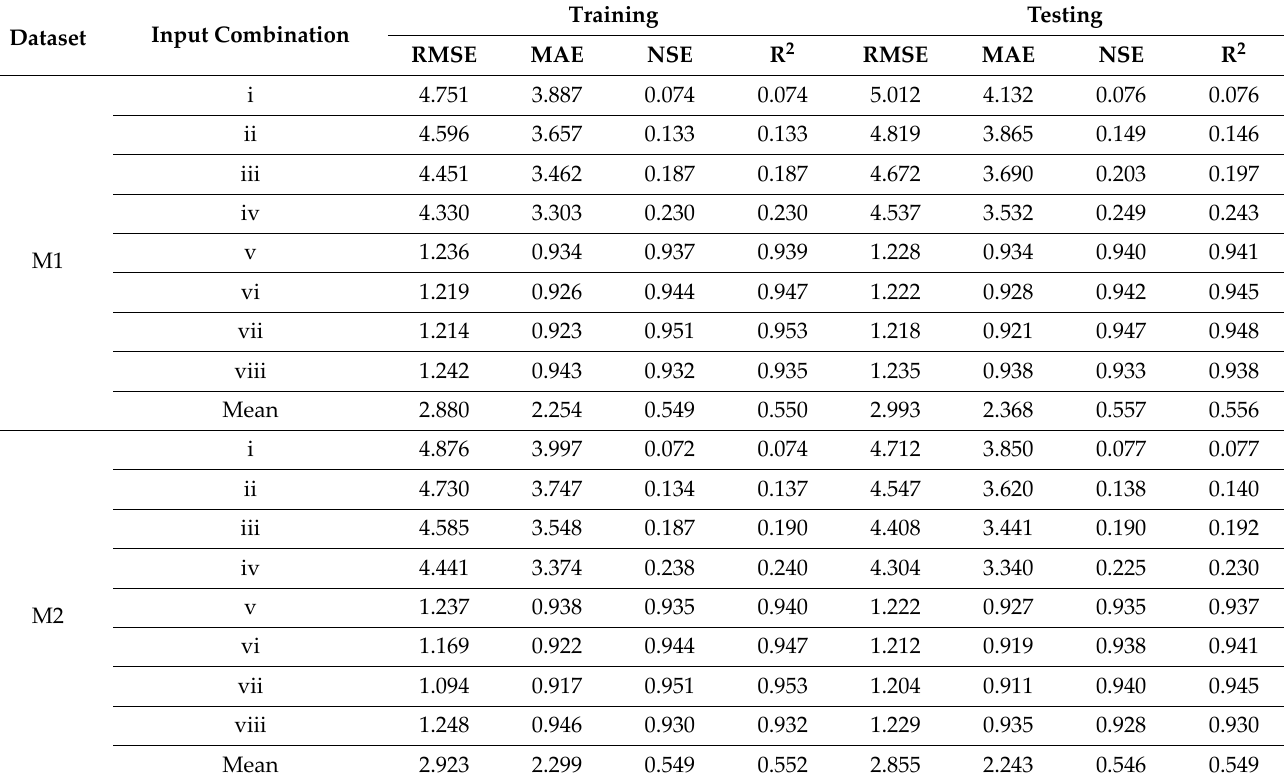
Table 10. The results of the model RVFL‑WCAMFO for daily time